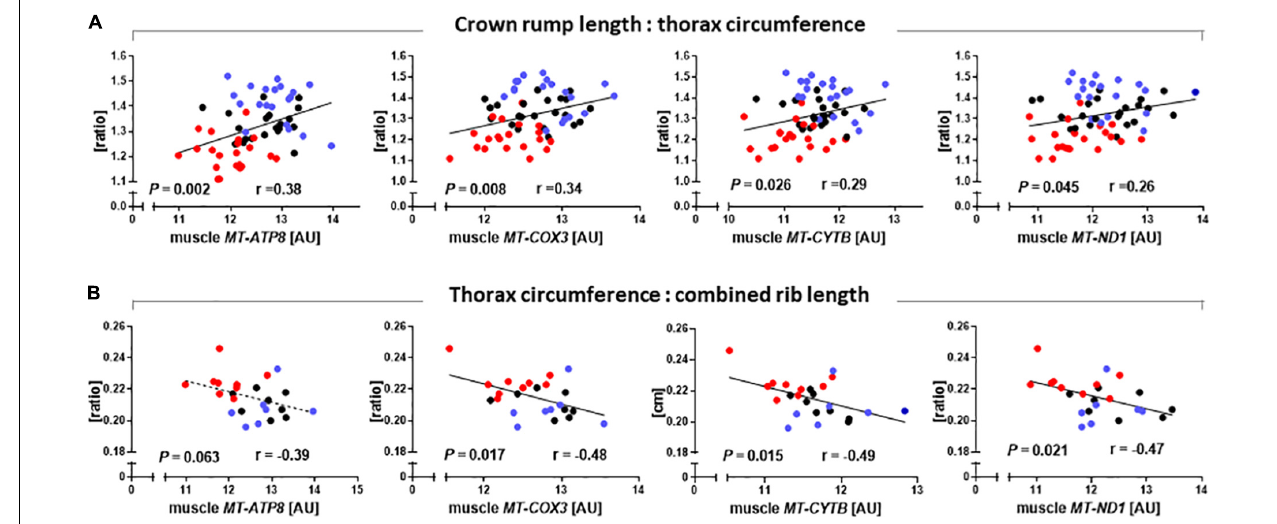
FIGURE 5 | Relationships between phenotypic parameters that reveal increased muscle mass of somatic cell nuclear transfer (SCNT) fetuses and mitochondrial gene expression in skeletal muscle. (A) Ratio of crown rump length to thorax circumference and (B) ratio of thorax circumference to combined rib length correlate with MT-ATP8 , MT-COX3 , MT-CYTB , and MT-ND1 transcript abundances in muscle of SCNT (red), in vitro fertilization (IVF, blue), and artificial insemination (AI, black) fetuses. Regressions are shown with Pearson correlation coefficients (r) and P- values. Mitochondrial gene expression is expressed in arbitrary units